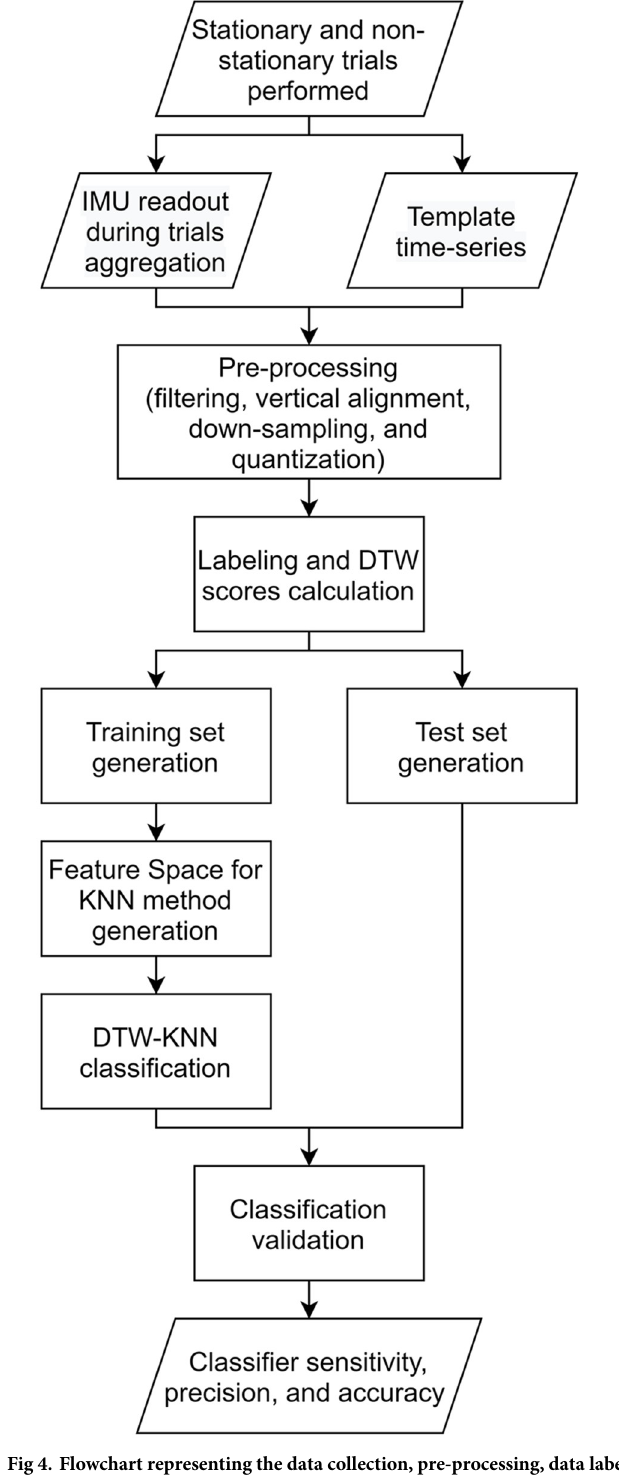
Fig 4. Flowchart representing the data collection, pre-processing, data labeling, feature extraction, classification, and validation.